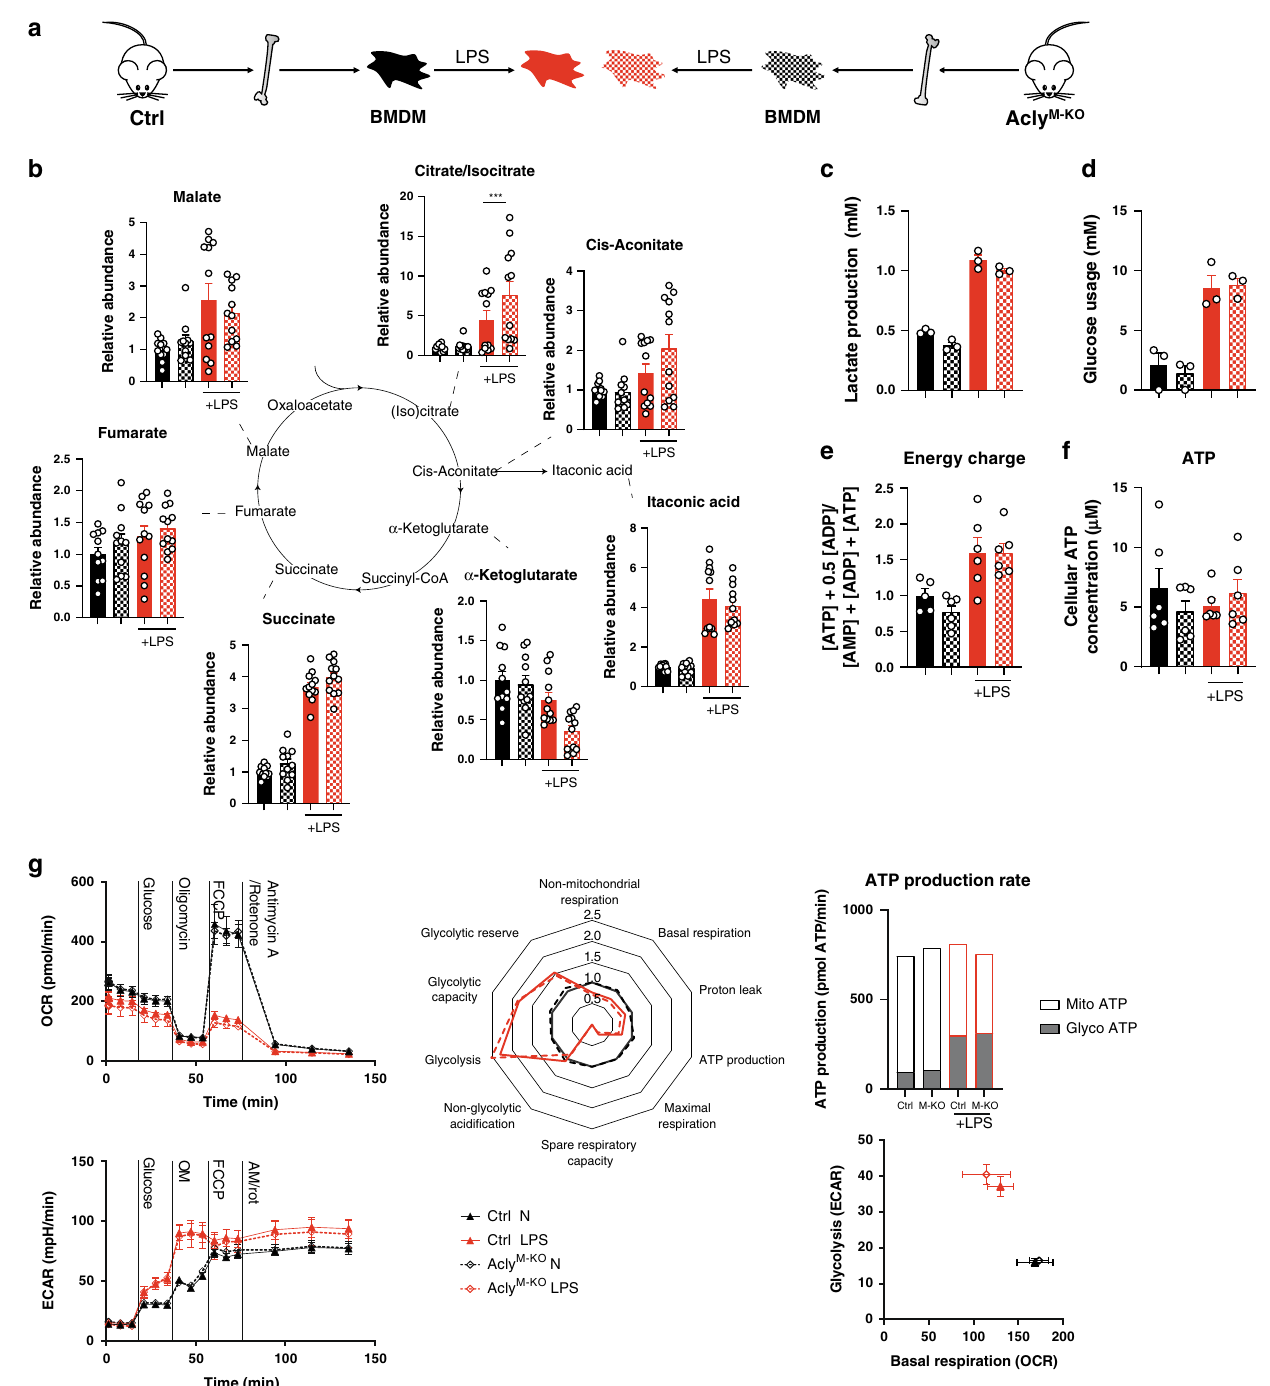
Fig. 5 Mitochondrial function remains unaltered in Acly M-KO BMDMs. a Differentiated control and AclyM-KO macrophages (BMDMs) were left untreated or stimulated with LPS ( b ) relative abundance of TCA cycle intermediates *** P < 0.0001. c Lactate secretion after 24 h LPS treatment. d Metabolized glucose in 24 h. e Cellular energy charge as calculated by [ATP] + .05[ADP]/([AMP] + [ADP] + [ATP]). f Cellular ATP concentration. g Seahorse analyses and extracted parameters. Values represent mean ± SEM from n = 12 technical replicates from two combined experiments b , n = 3 technical replicates from three pooled mice from one of three representative experiments ( c , d , g ), n = 6 technical replicates from three pooled mice from one of two representative experiments ( e , f ). *** P < 0.001 by two-way ANOVA with Bonferroni post hoc test for multiple comparisons. Source data are deposited in MTBLS2159 ( b ) or provided as a Source Data fi le ( c – g and Acly M-KO macrophages (Fig. 7a, b). Conversely, levels of measured fatty acid levels in control and Acly M- KO macrophages by performing lipidomics measurements. Whereas RNA- omega 3 and 6 fatty acids, including arachidonic acid (AA) ten- sequencing analysis suggested a lipid-laden phenotype of ded to be increased in Acly M-KO macrophages (Fig. 7c, d). Acly M-KO macrophages, total lipid pools were similar in control Cyclooxygenase (COX)-1 and COX-2 produce prostaglandins